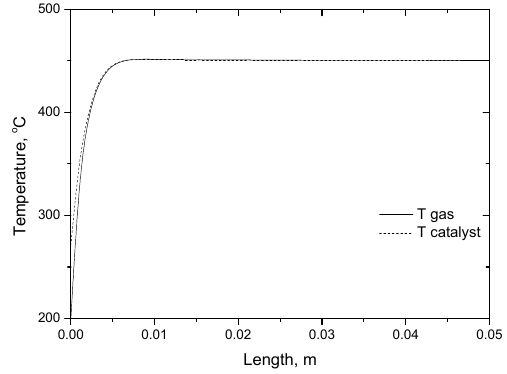
Figure 17. Temperature evolution in gas phase (T gas ) and solid phase (T catalyst ) along the reactor length at the inlet temperature of 200 °C.